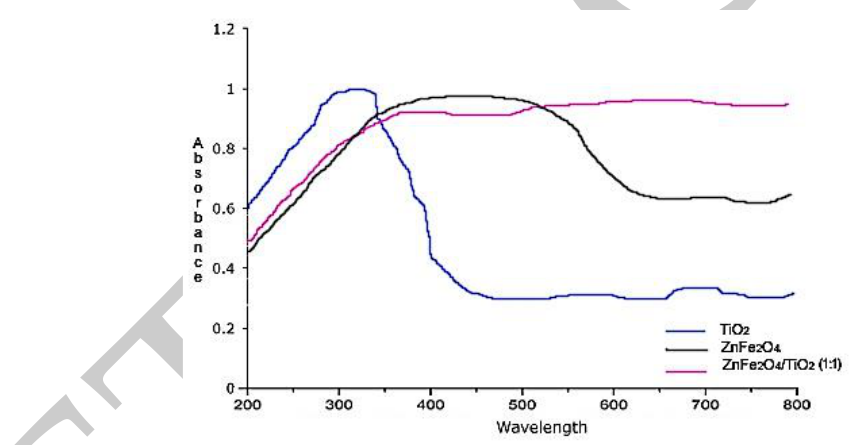
Figure 2. UV–Vis spectra of the synthesized photocatalyst; the wavelength set was 200–800